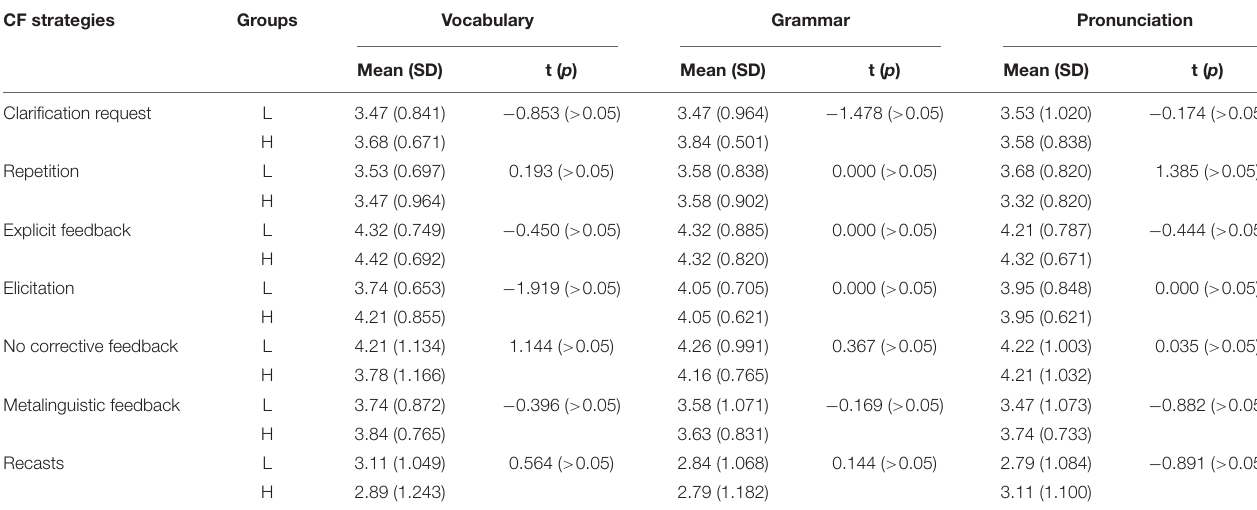
TABLE 3 | High- (H) and low-accuracy (L) group responses to corrective feedback (CF) strategies. CF